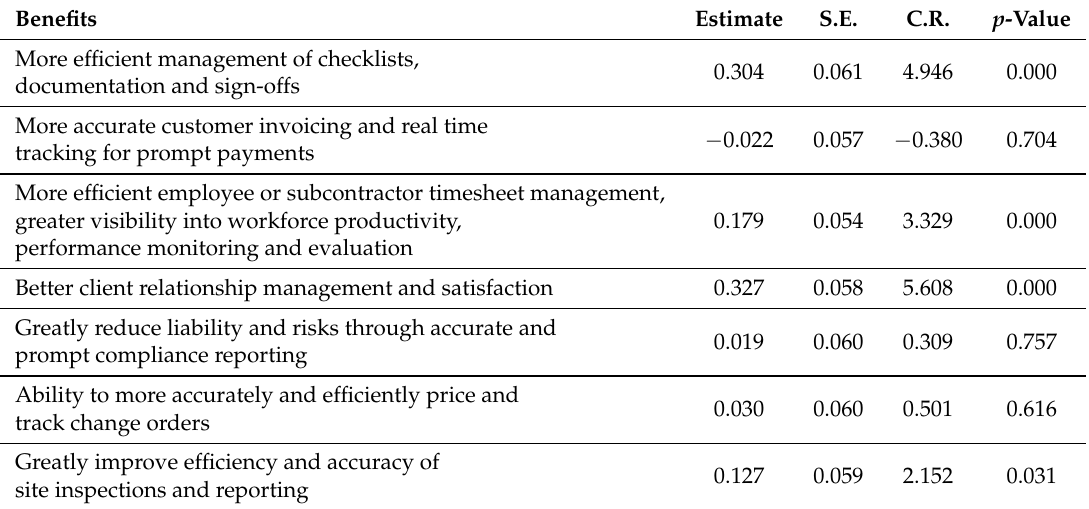
Table 6. Regression Weights of Perceived Benefits of the Use of Apps Towards Overall